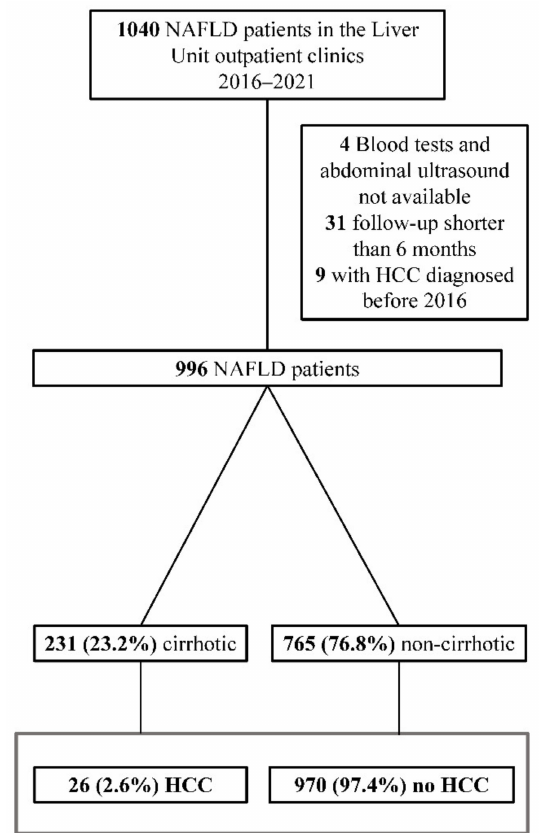
Figure 1. Flowchart of patients’ disposition. HCC: hepatocellular carcinoma.